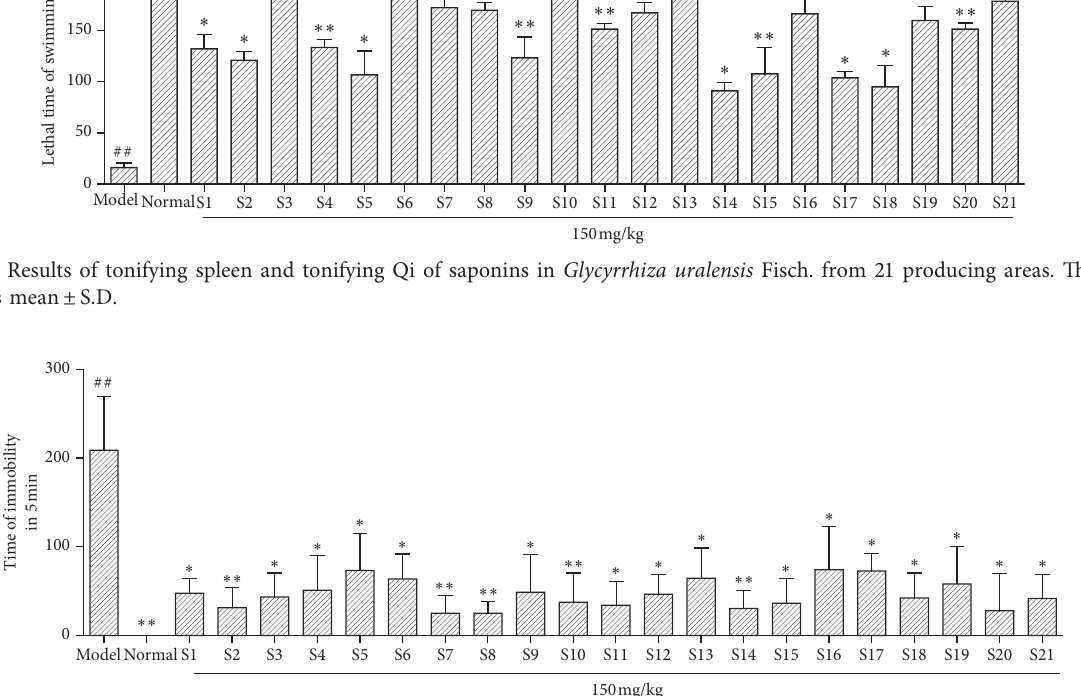
Figure 5: Results of saponins from Glycyrrhiza uralensis Fisch. from 21 habitats suspended from the tail of mice. The result represents mean ± S.D. Note: Compared with the normal group ratio, ## P < 0 . 01 was an extremely significant difference. Compared with the model group, ∗ P < 0 . 05 P < 0.05 means there is a significant difference, ∗∗ P < 0 . 01 P < 0.01, with an extremely significant difference ( n �